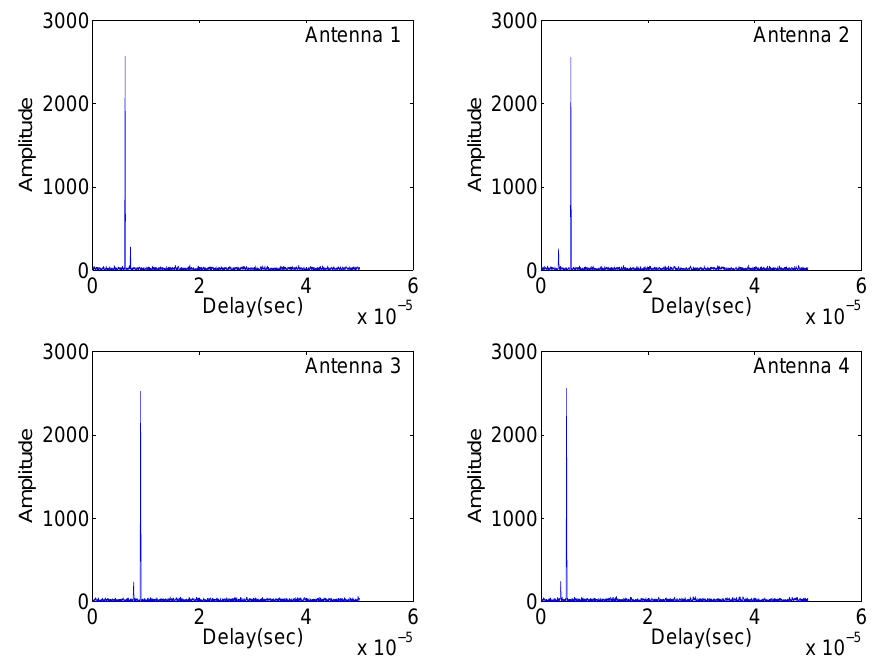
Figure 2. Matched filtering outputs of the four antennas in Case (1).